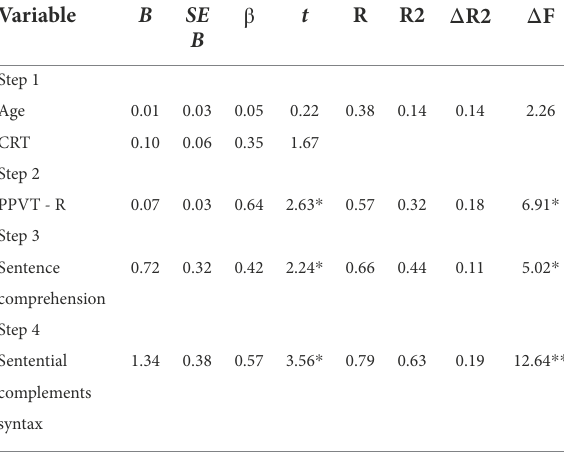
TABLE 3 Regression analysis results of nonverbal FB for the ASD children.